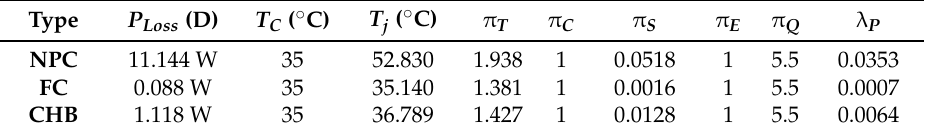
Table 5. The calculated base failure rates for diodes.